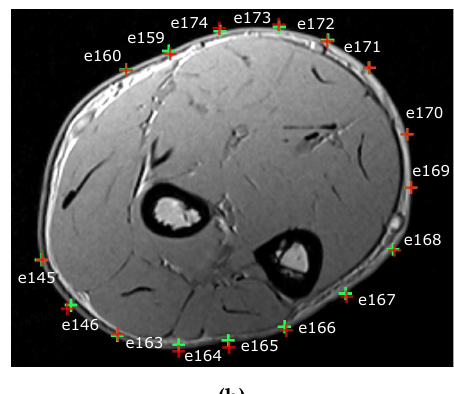
Figure 4. ( a ) The projection of the electrodes closest to the selected slice plane. The real electrodes position is indicated with a red sphere, the MRI plane is indicated with a red line and the projected position is indicated with a light blue sphere. The projection is depicted with a green arrow. ( b ) Section of the MRI with the position and the number of the electrodes. The projection of the electrode 3D position on the 2D slice is represented with a red cross. Such points are further projected on the skin (green cross) to find the closest position on the forearm surface. Table 1. Distance error in the projection of the electrodes’ positions. The distance errors in the projection on the selected slice as shown in Figure 4a are reported on first two rows of the table. The distance errors during the projection of the position on the skin surface as shown in Figure 4b are reported on the bottom two rows. For each of the subjects, the mean and the maximum distance errors are reported. Subject 1 Subject 2 Subject 3 Subject